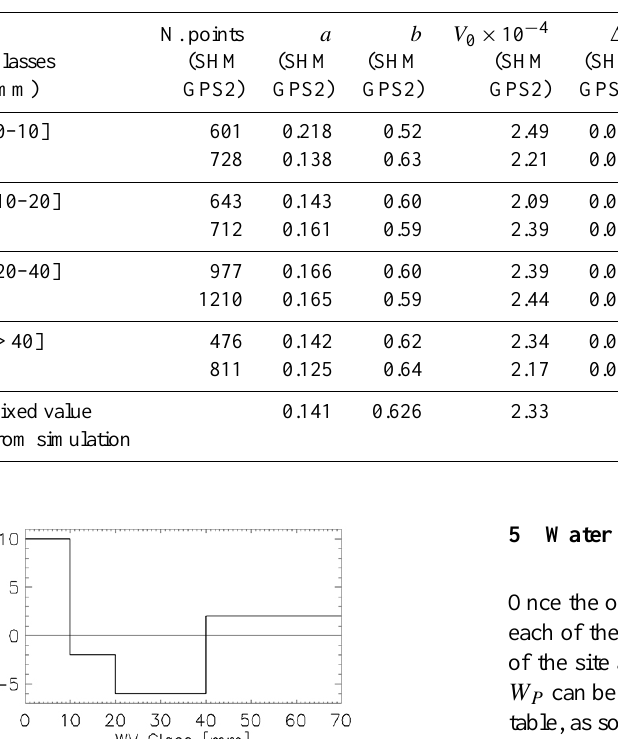
Table 2. Number of data points for each classes; optimal values of a,b and V 0 for each water vapour class and their estimated errors; estimated uncertainties of W P .